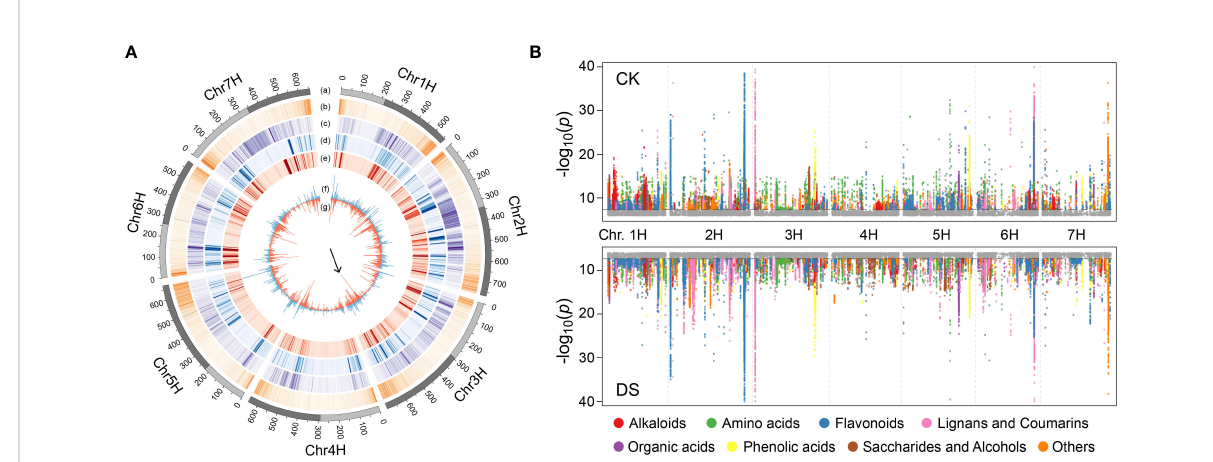
FIGURE 4 mGWAS of qingke under CK or DS condition. (A) Chromosomes distribution of genomic features involved in mGWAS. Lane a: long (dark grey) and short (light grey) arm of chromosome; Lane b: density (per Mb) of annotated genes; Lane c: density (per Mb) of SNP; Lane d: density (per Mb) of signi fi cantly associated loci in mGWAS under CK; Lane e: density (per Mb) of signi fi cantly associated loci in mGWAS under DS; Lane f: histogram (per 5Mb) of lead SNP in mGWAS under CK; Lane g: histogram (per 5Mb) of lead SNP in mGWAS under DS. The arrow highlights the difference in lead SNP density between CK and DS group at chr3H:485-490Mb. (B) Manhattan plots of mGWAS showing genetic associations for the annotated metabolites under CK or DS condition. The strength of association for the metabolites is indicated as the negative logarithm of the P- value for the LMM model. All metabolite-SNP in signi fi cantly associated loci were plotted in